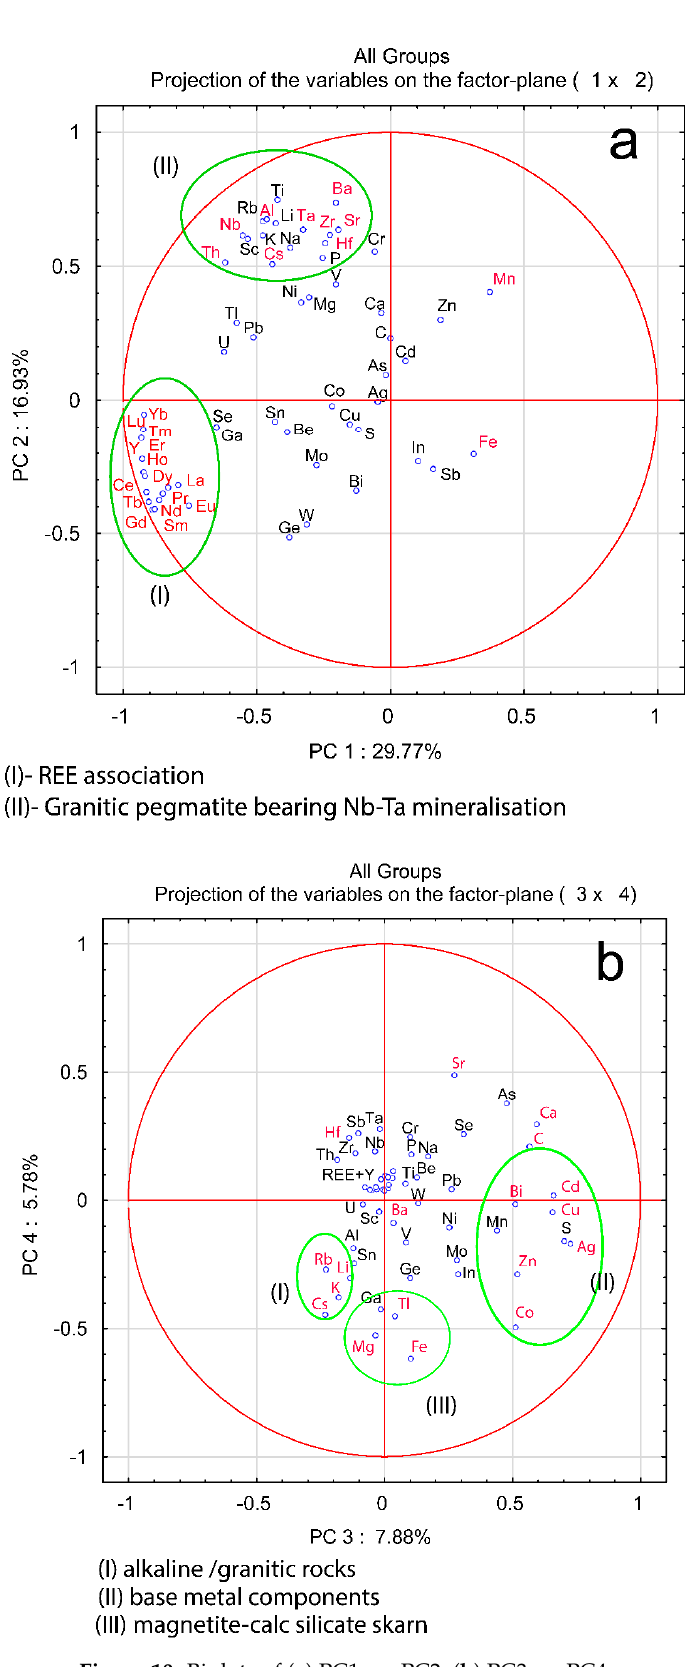
Figure 10. Biplots of ( a ) PC1 vs PC2; ( b ) PC3 vs PC4.